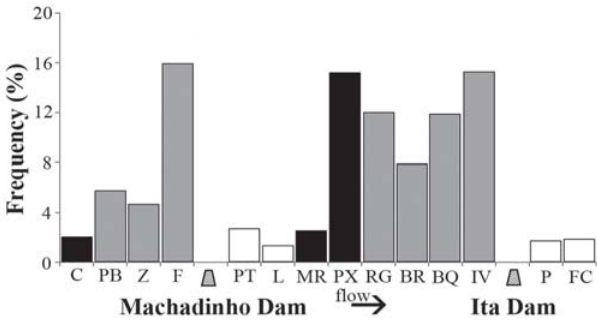
Fig. 3. Relative abundance of Acestrorhynchus pantaneiro captured at different sampling sites (Lentic [gray bars]: PB = Pelotas Barracão, Z = Zortea, F = Forquilha, RG = Rancho Grande, BQ = Barra dos Queimados, BR = BR-153, IV = Itá Velha; Transition [black bars]: C = Canoas, PX = Peixe, MR = Marcelino Ramos, Lotic [white bars]: PT = Pelotas Túneis, L = Ligeiro, P = Palomas, FC = Foz do Chapecó).